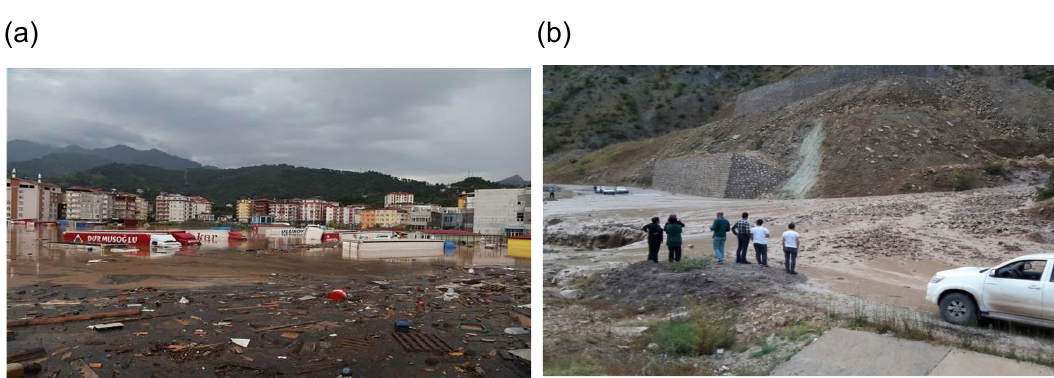
Figure 2. Photos showing the destructive effects of the 24 August 2015 flash floods and landslides: (a) Hopa city center flash flood and (b) landslide in